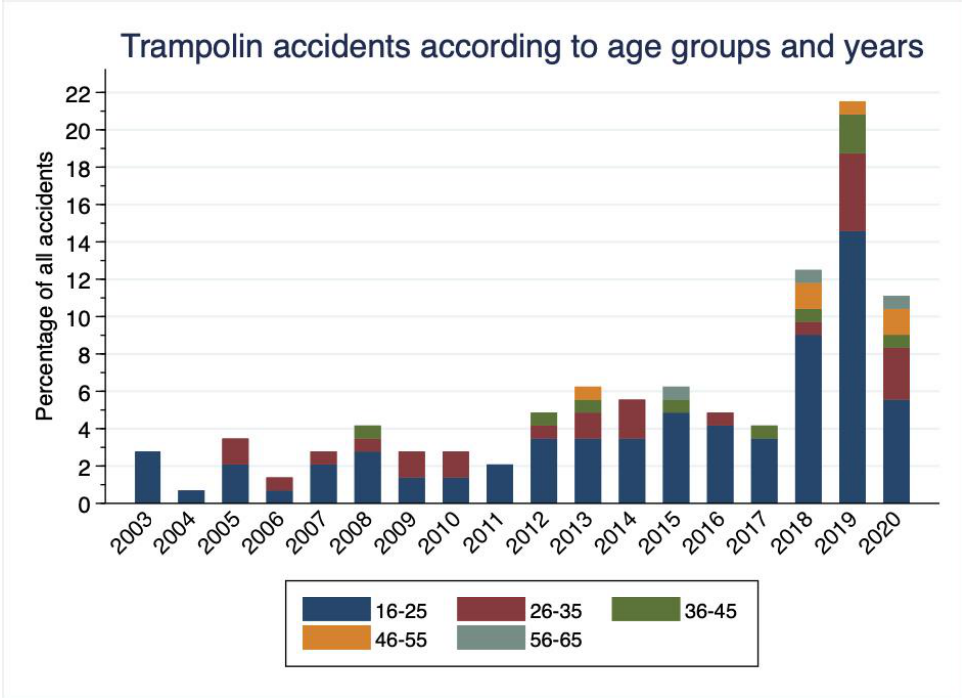
Figure 3. Trampoline accidents according to age groups and years.